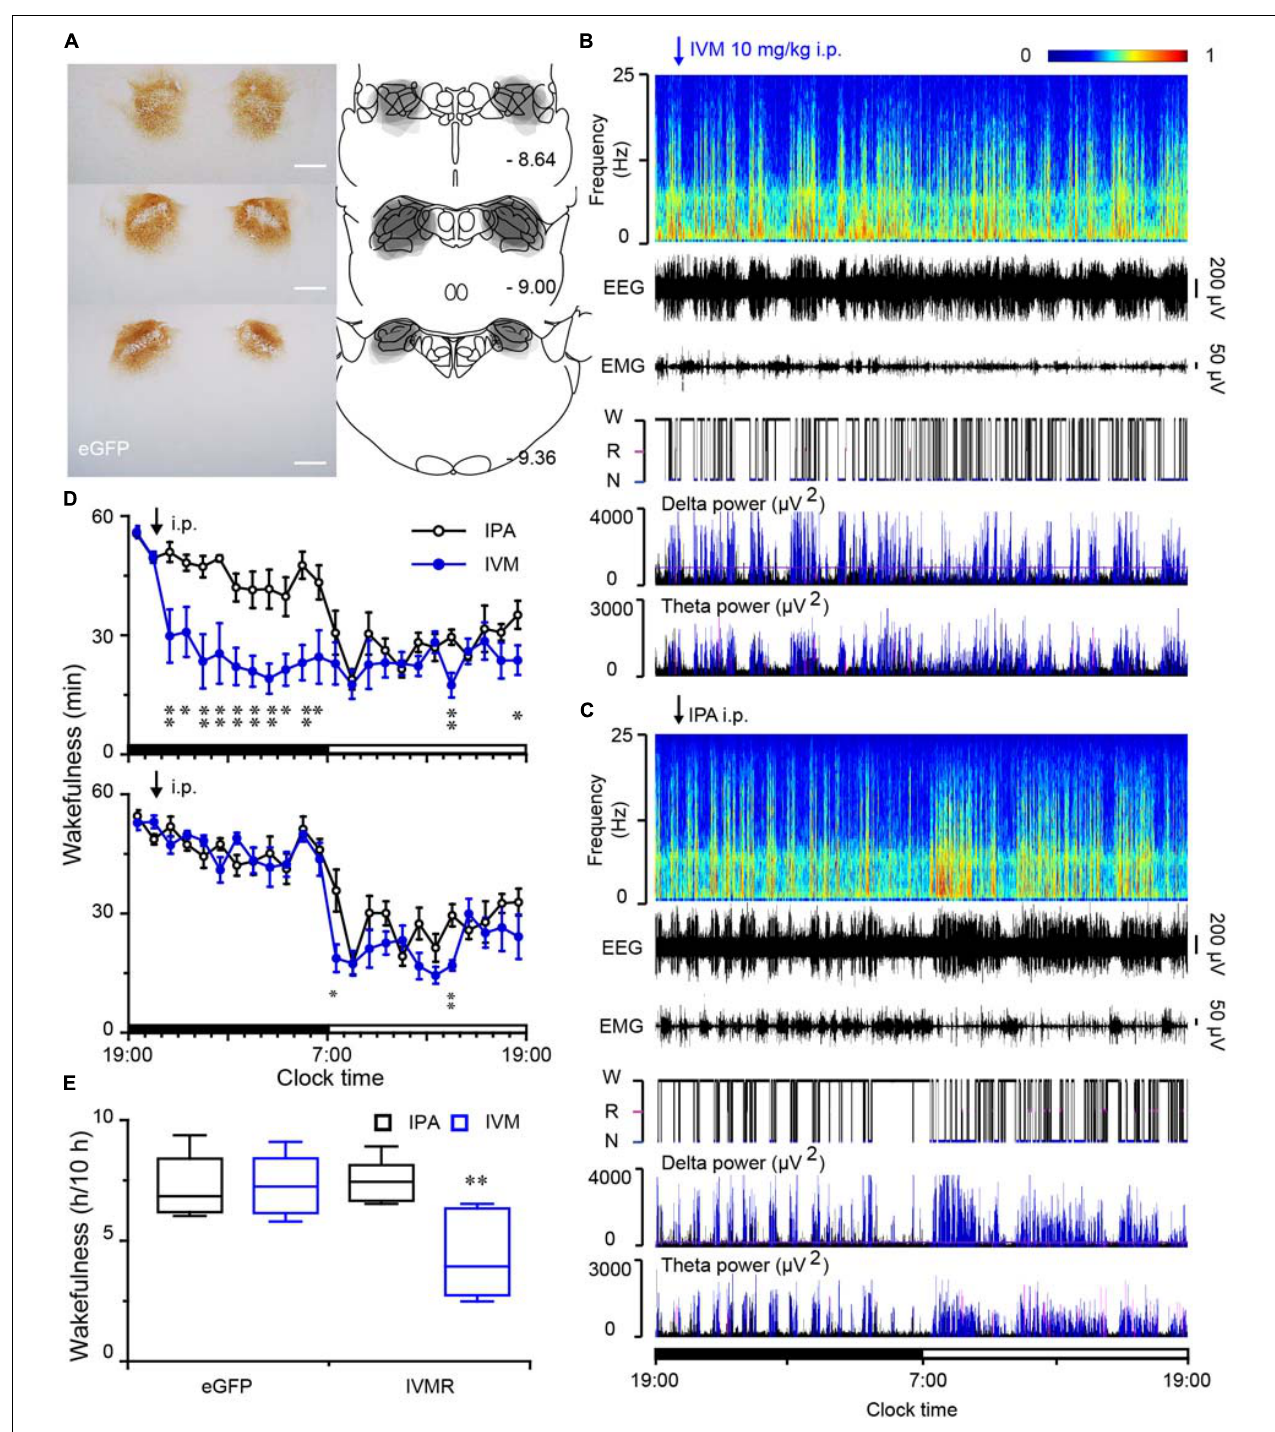
FIGURE 7 | Chemogenetic inhibition of PB neurons decreased wakefulness in rats during the active period. (A) Brain section stained against eGFP to confirm IVMR expression in the PB. Injection sites were mapped on coronal atlas drawings at three different levels containing the PB. Superimposed eGFP expression areas in the PB of 6 AAV-injected rats are shown in the right panels. Scale bars: 1 mm. (B,C) Typical examples of EEG power spectra, EEG, EMG, hypnogram, and relative magnitude changes in delta and theta power over 24 h for the same rat given IVM (B) or IPA (C) . W, wakefulness; R, REM sleep; N, NREM sleep. (D) Time courses of wakefulness in rats after the administration of IVM (10 mg/kg) or IPA in IVMR rats and eGFP controls, respectively. (E) Amount of wakefulness during 10 h after IVM or IPA injection in IVMR and eGFP rats. * P < 0.05, ** P < 0.01, compared with the IPA treatment ( n = 6).